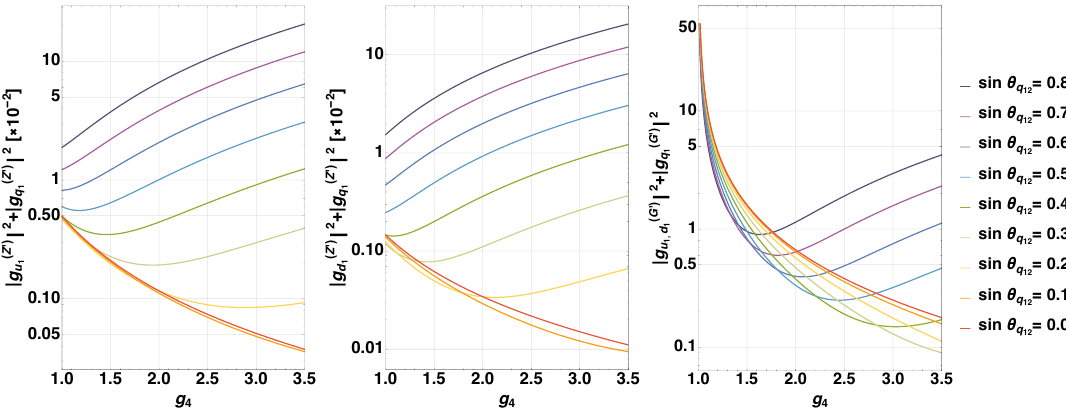
Figure 1 . First-generation coupling combinations relevant for Z 0 searches through the vertex Z 0 (cid:22) uu (left), Z 0 (cid:22) dd (center), or for G 0 searches through the vertices G 0 (cid:22) uu or G 0 (cid:22) dd (right). Within our model, a combination of the parameters v by B -physics data alone, in particular by the R ( D ( (cid:3) ) ) discrepancies. A global (cid:12)t of v the constants (cid:12) (cf. eq. (2.15)) was performed in ref. [51]. Expressed in our notation, the (cid:12)t prefers values for v While the preferred value of v DM phenomenology is essentially independent of the latter two parameters. Consequently, for any reasonable value of v